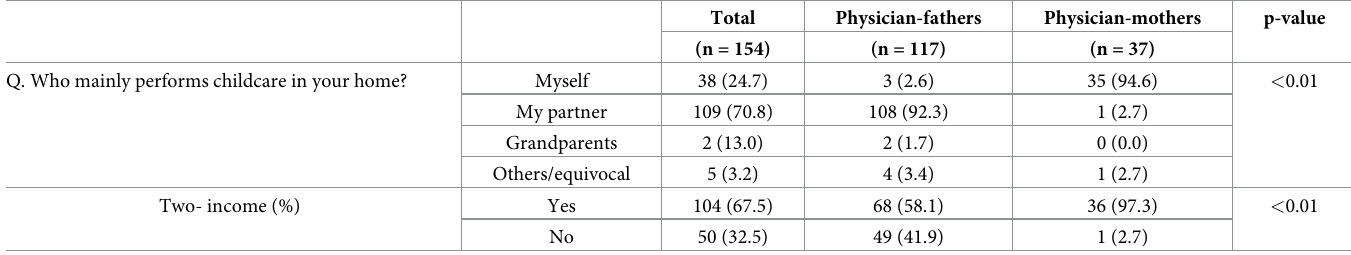
Table 4. Results of the questionnaire survey regarding childcare and family style.